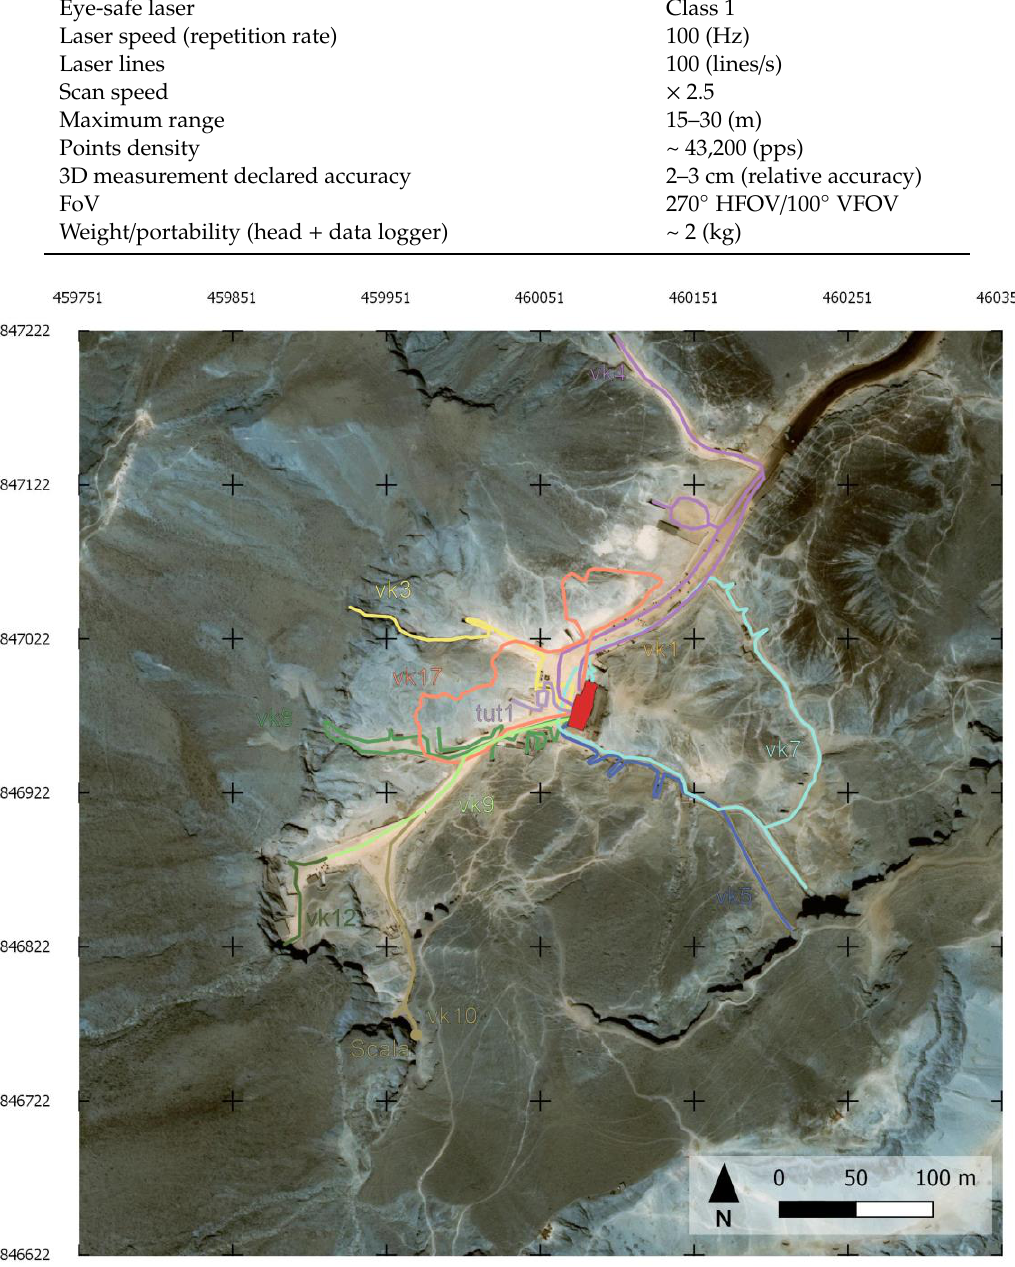
Figure 4. General map of the more than thirty scan trajectories acquired by the MMS platform in the VOK. Different colors represent different surveyed paths.